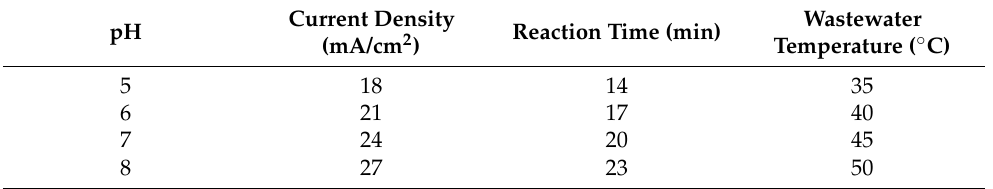
Table 2. The level of each parameter.